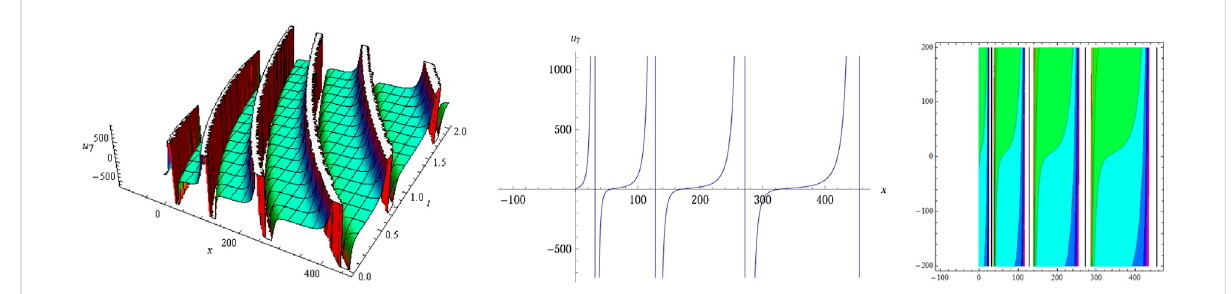
FIGURE 9 3D plot, 2D plot, and contour plot of u 7 with α (cid:2) 0 . 6 , β (cid:2) 0 . 6.